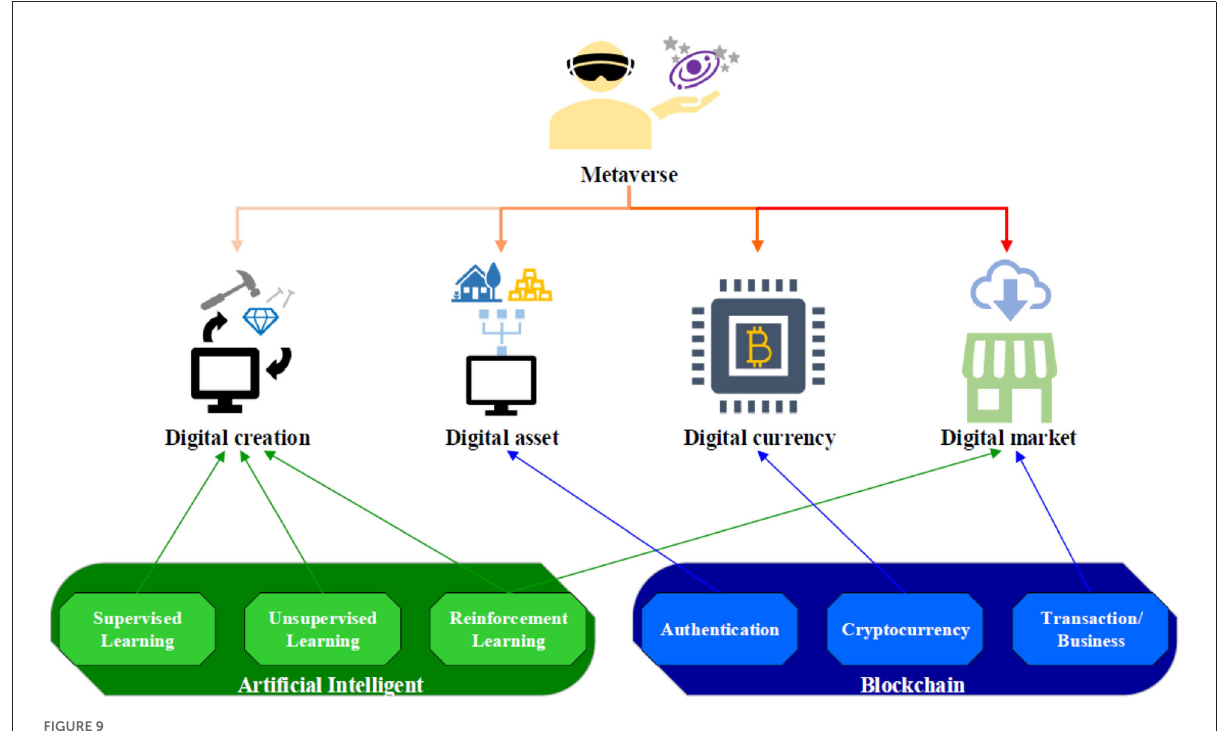
FIGURE9 Collaborative system of metaverse, AI, and blockchain (Ynag et al.,